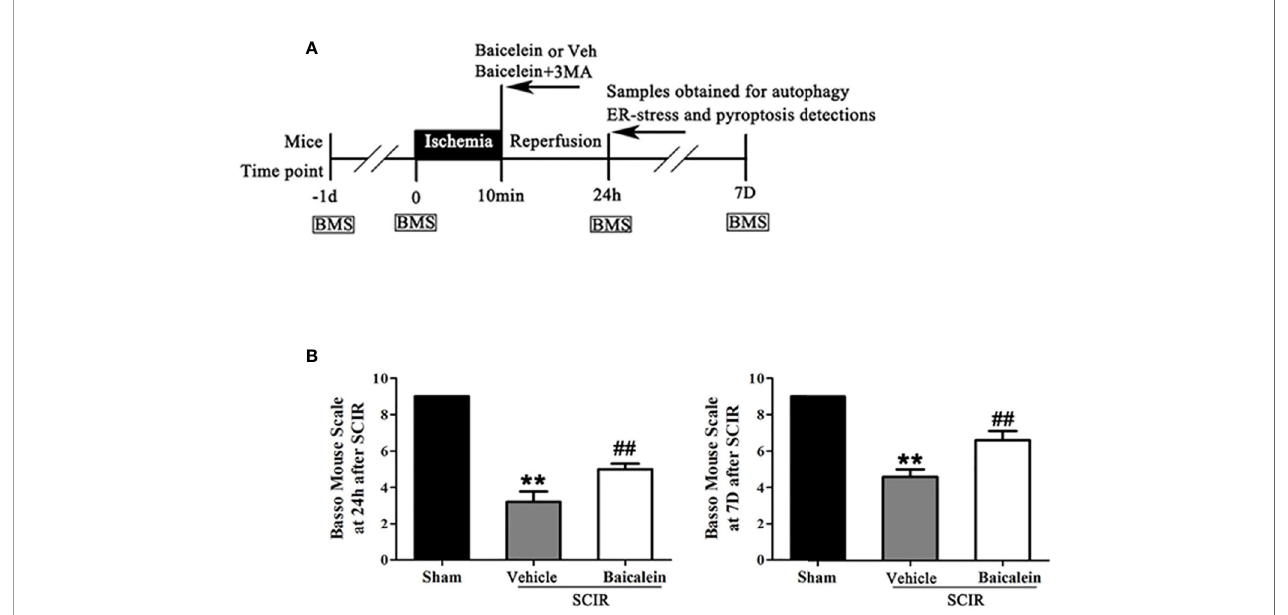
FIGURE 1 | Baicalein promotes functional recovery after spinal cord ischemia-reperfusion injury (SCIR). (A) Schematic diagram of the experimental design. Each group received vehicle, baicalein (100 mg/kg, ip ), or baicalein plus 3-methyladenine (3MA) (15 mg/kg, ip ). Mice received these treatments at the beginning of reperfusion and were sacri fi ced at 24 h and 7 days after SCIR. (B) BMS scores of mice in the Sham, SCIR+Vehicle, and SCIR+Baicalein groups at 24 h and 7 days after SCIR. The values are expressed as the means ± SEM, n = 5 per group. **p < 0.01, vs. Sham group. ## p < 0.01, vs. SCIR+Vehicle